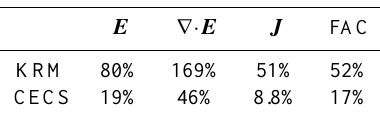
Table 3. Errors in the WTS results calculated by the KRM and CECS methods. Error is calculated using Eq. (24) and data pre- sented in Figs. 9 and